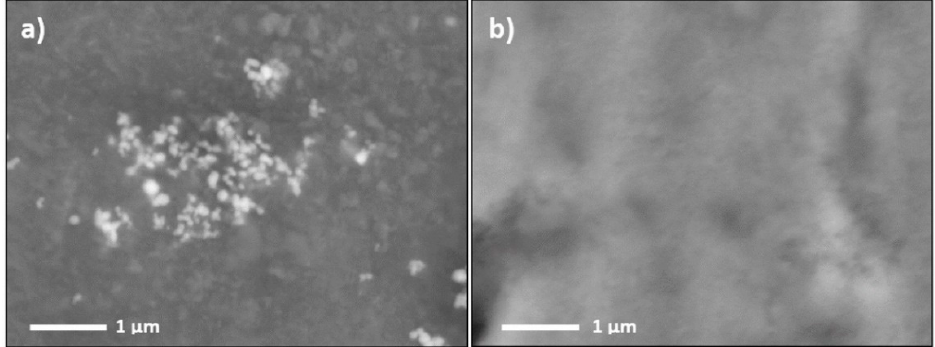
Figure 4. SEM images of SiO 2 coatings ( a ) with SnO 2 nanoparticles and ( b ) absence of SnO 2 nanoparticles.